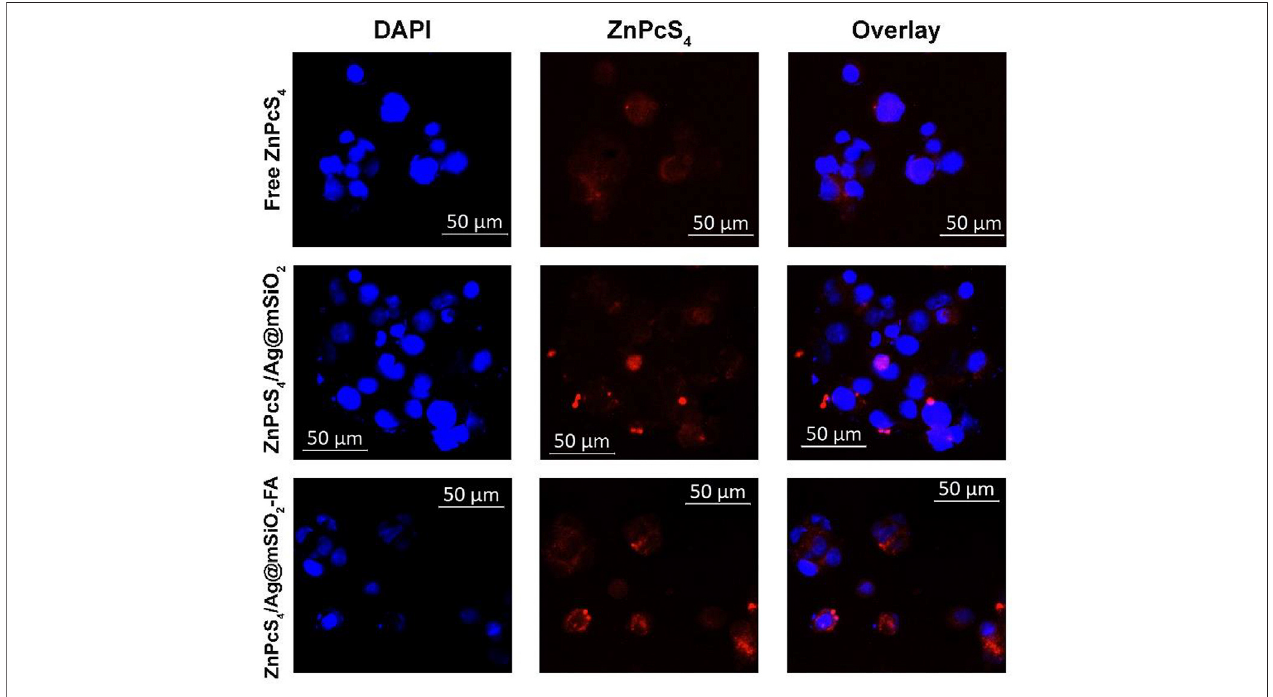
FIGURE 3 | Subcellular localization of passive and actively targeted NCs in Caco-2 cells. Blue fl uorescence is indicative of DAPI-stained nuclei and red auto fl uorescence shows the localization of the PS or the